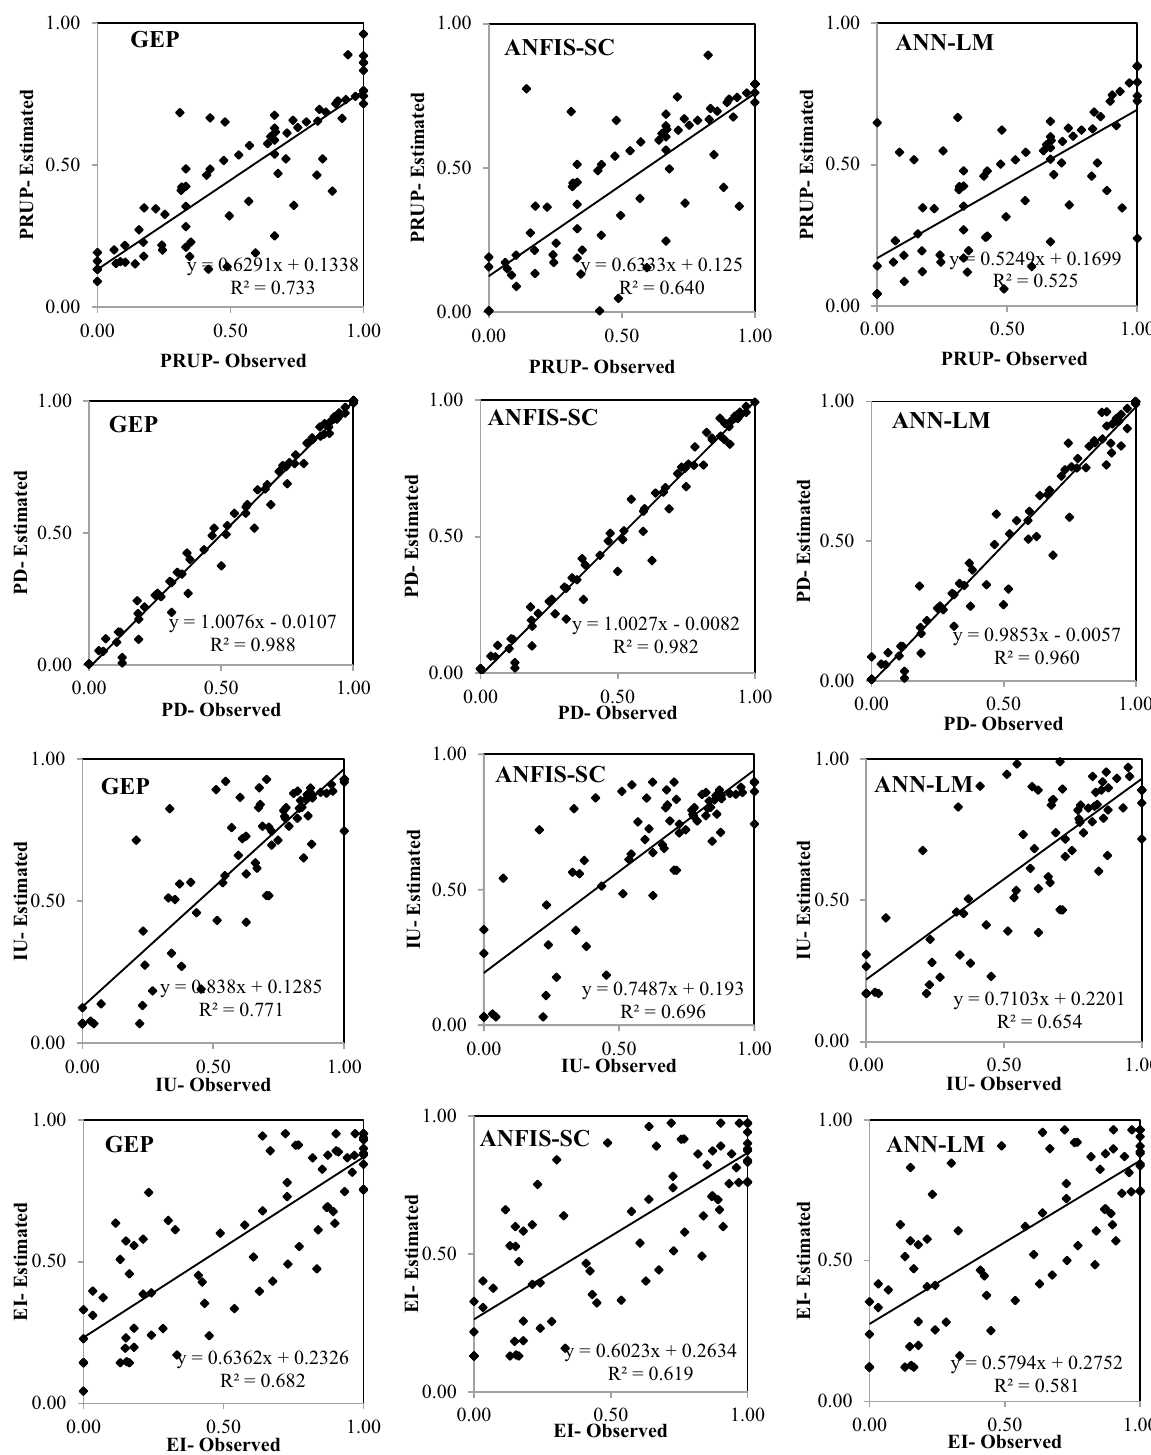
Figure 9. Observed and estimated social parameters during the testing period in